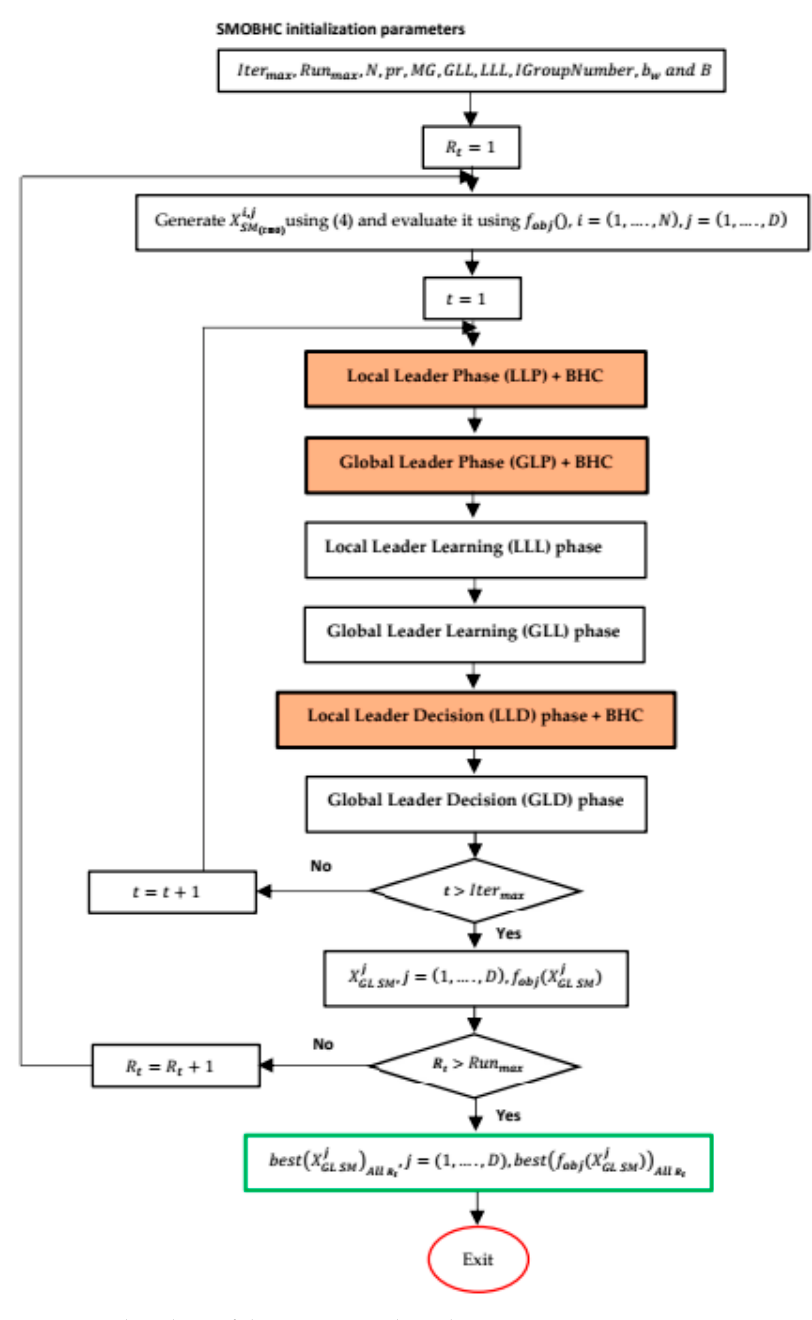
Figure 6. Flowchart of the SMOBHC algorithm.